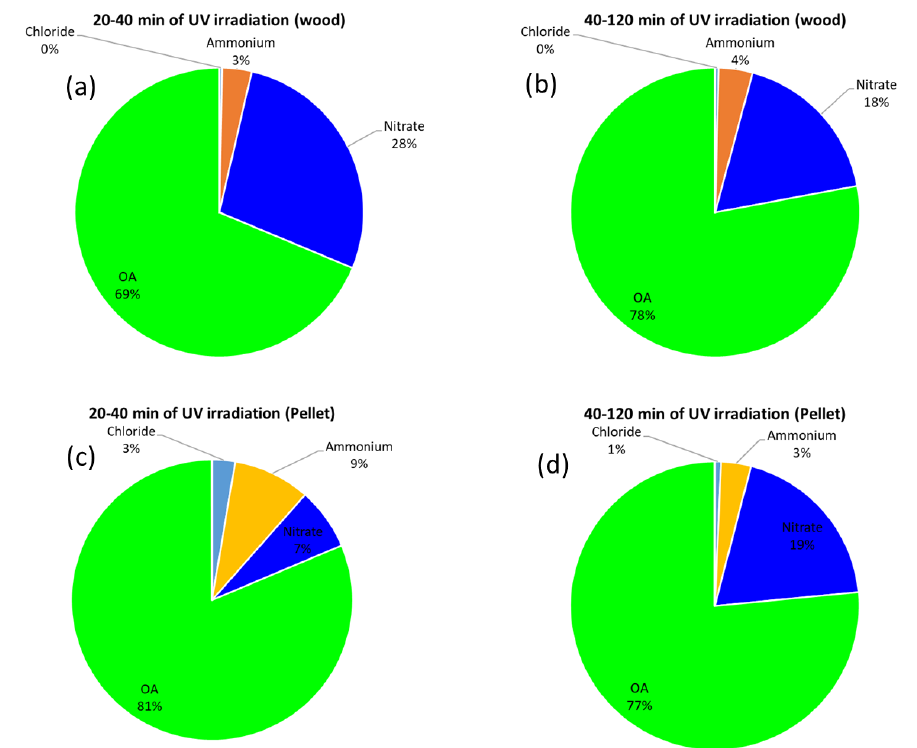
Figure 5. Average of several experiments in Chemical composition of PM 1.0 non-refractory particles during UV irradiation. ( a ) Filtered emissions for wood from 20 to 40 min. of irradiation ( b ) Filtered emissions for wood from 40 to 120 min. ( c ) Emissions from pellets (20 to 40 min.) ( d ) Emissions from pellets for 40 to 120 min.